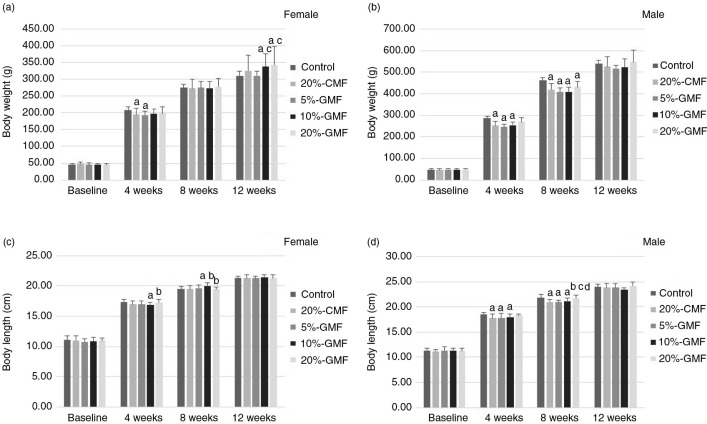
Effect of GMF on body weight and body length trends in Sprague-Dawley rats treated with different levels of GMF, shown by body weight (a, female; b, male) and body length (c, female; d, male). aStatistical significance: p<0.05, compared with control; bstatistical significance: p<0.05, compared with 20%-CMF; cstatistical significance: p<0.05, compared with 5%-GMF; dstatistical significance: p<0.05, compared with 10%-GMF. GMF: goat milk–based formula.